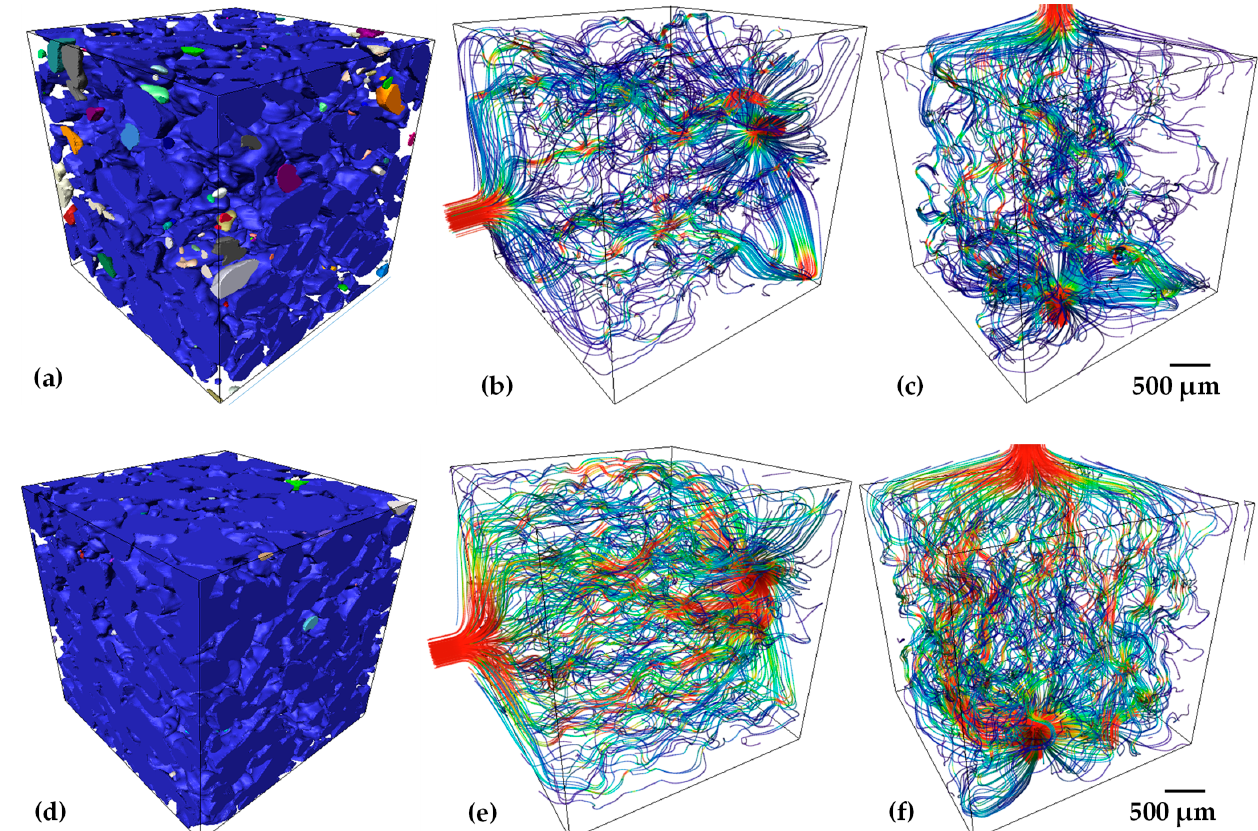
Figure 10. 3D volume renderings of porosity, with colors depicting connected pores, and streamlines for the simulated flow of blood through the pores in the vertical and horizontal directions, with the colors depicting fluid velocity, for samples with 30 wt.% of Ta and either 30 vol.% ( a – c ) or 40 vol.%; ( d – f ) of salt particles.